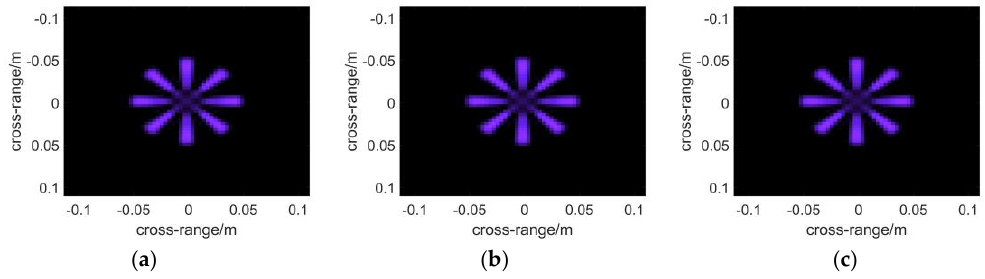
Figure 9. The 3-D reflectivity figures are presented which are calculated with the algorithm of: ( a ) BPA; ( b ) RMA; ( c ) PMA.